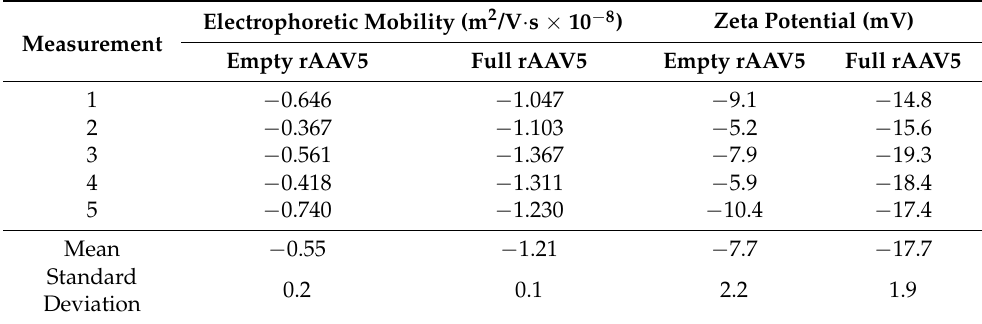
Table 7. Electrophoretic mobility and zeta potential values for full and empty rAAV5 samples measured in PBS with 0.001% Pluronic F-68 buffer.